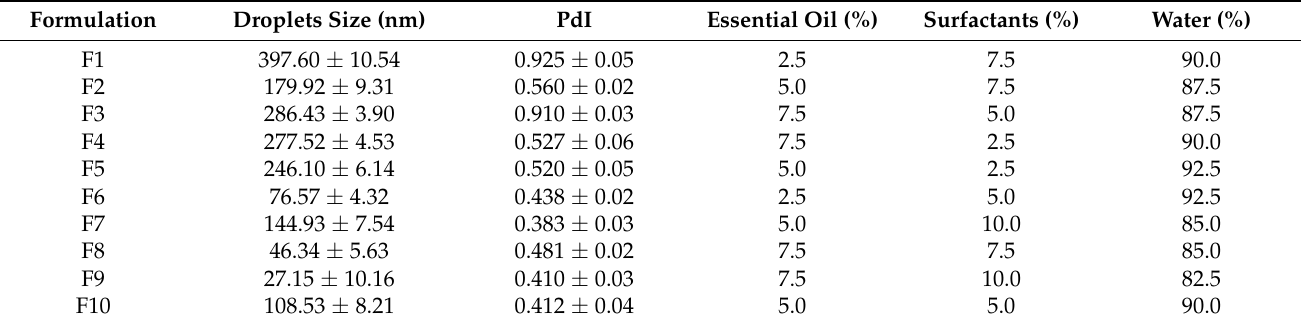
Table 3. Arrangement of the optimization of the ESON with the amount of ESO, surfactants blend, water, droplets size, and PdI